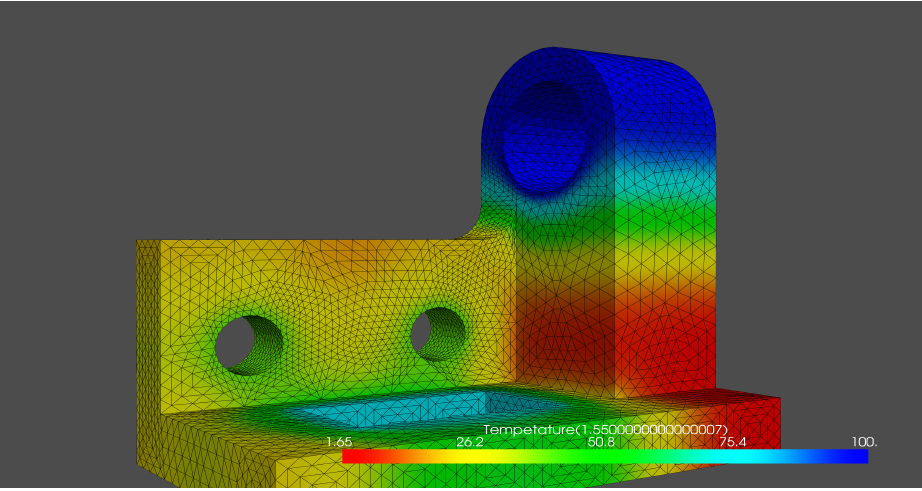
Figure 10. Temperature contour of a function space of order 1 at t = 1.55